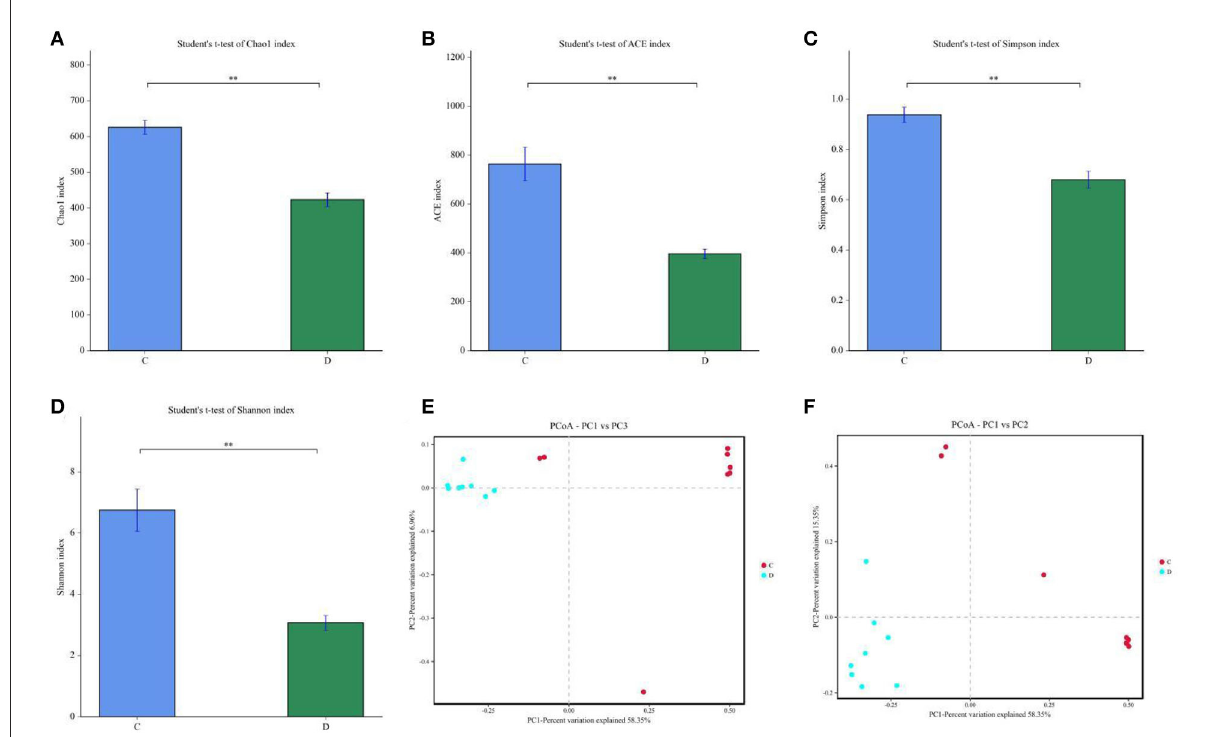
FIGURE2 Effects of diarrhea on gut fungal diversity in horses. (A–D) represents the Chao1, ACE, Simpson and Shannon indices that can reflect the diversity of gut fungal community (E,F) Principal Coordinate Analysis (PCoA) of gut fungal community in healthy and diarrheic groups. C and D represent healthy and diarrheic groups, respectively. Data was presented as the mean ± SD. ** P < 0.01.